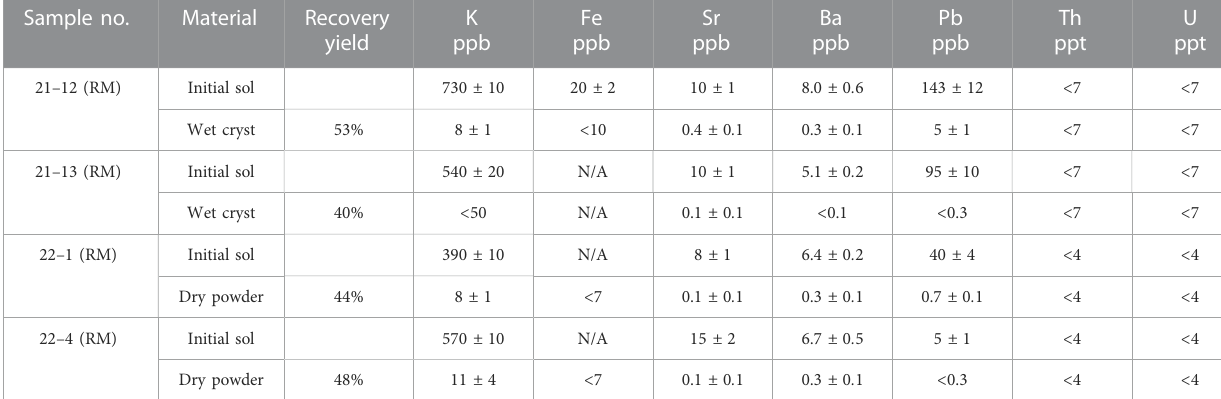
TABLE 5 The ICP-MS result of residual melt recovery experiment in different batches of mass production. It is marked as (RM) for the naming, and the Initial solution is the residual melt solution after dissolving melt and fi ltration of the quartz particles. The Wet crystal samples were taken after recrystallization and washing with ethanol. Uncertainties are given at 90% C.L, and upper limits are given at 95% C.L. Sample no.